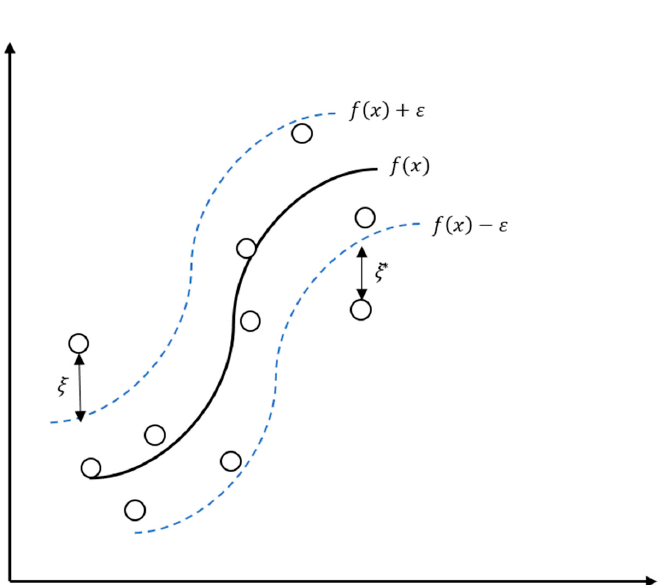
Figure 3. Schematic diagram of non-linear support vector regression.